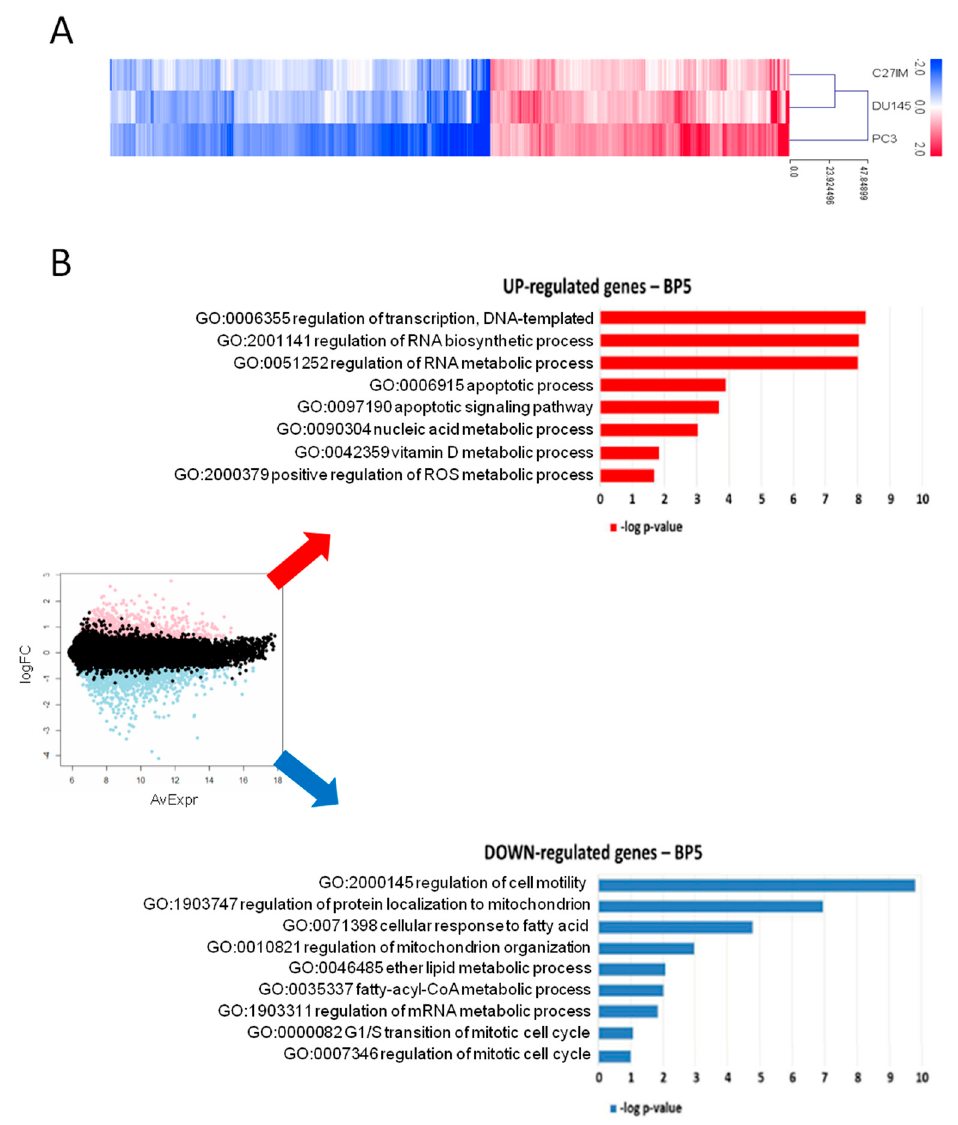
Figure 2. Gene profiling after MALAT1 silencing. ( A ) Heatmap of differentially regulated tran- scripts (log2 FC > 0.58, namely FC > 1.5; p < 0.01) in PC3, DU145, and C27IM cell lines transfected with MALAT1gapmer vs. LacZgapmer (2 biological replicates each, with dye-swap technical repli- cates). Cell line means log2 FC are represented with red stripes for upregulated genes ( n = 1237) and blue for downregulated genes ( n = 1574), as listed in Table S2. ( B ) MA plot with differentially regulated genes highlighted in red and blue (left), and most representative categories of overrepresented biological processes in overexpressed genes (red histograms) and underexpressed genes (blue histograms), according to gene ontology enrichment analysis (right). Histogram length is proportional to the statistical significance of the enrichment ( − log10 of enrichment p -value).